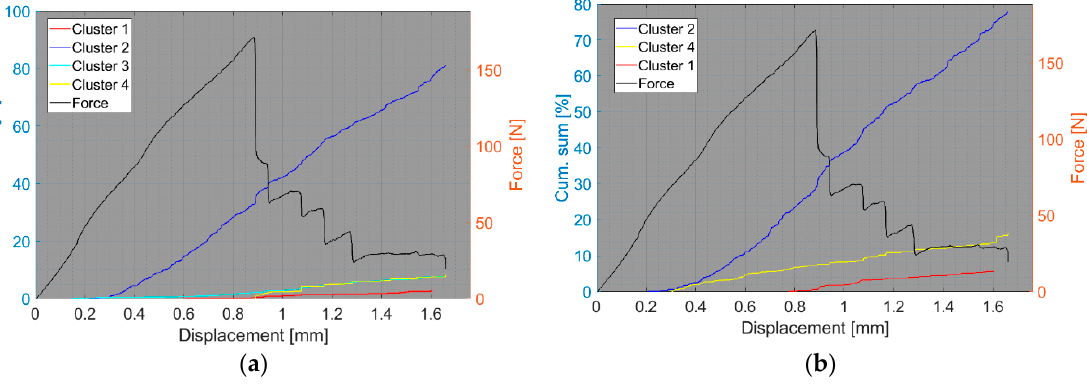
Figure 24. Cumulative sum of hits of individual clusters, including force versus displacement—CPCT samples: ( a ) Fujicera 1045S dataset; ( b ) DWC 454 dataset.